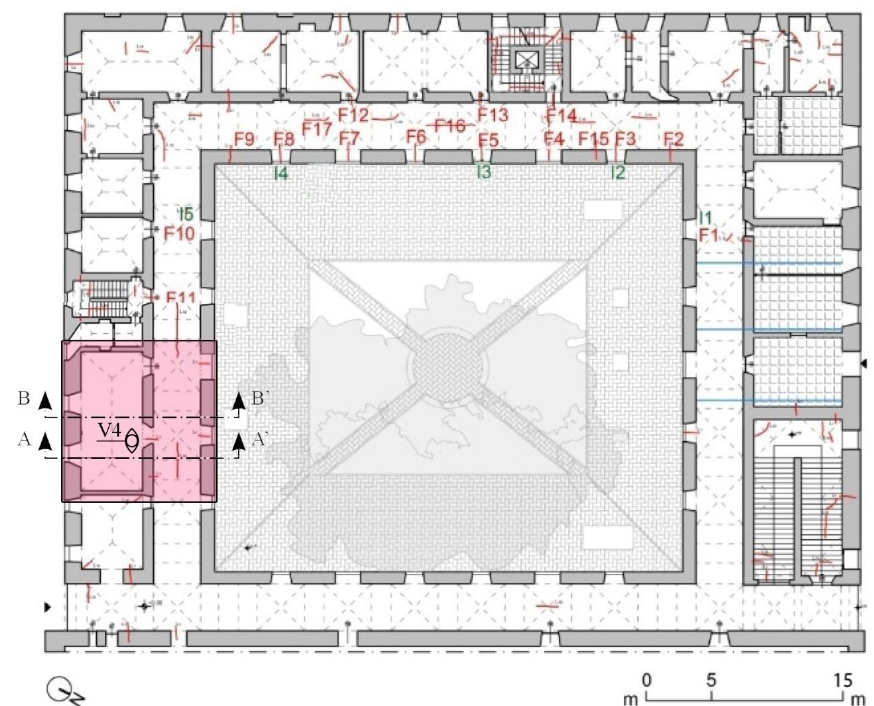
Figure 3. Survey of plan of the first floor completely out ground (level of the Church of Montemorcino Nuovo; h = 0.0 m): red lines—main lesions on the vaults, blue lines—steel tires installed after the 1997 earthquake. Location of the monitoring instruments: F1 – F17 crack-meters, I1 – I5 inclinometers, V4 videoendoscopy. The span selected for the following FEM is highlighted in red.